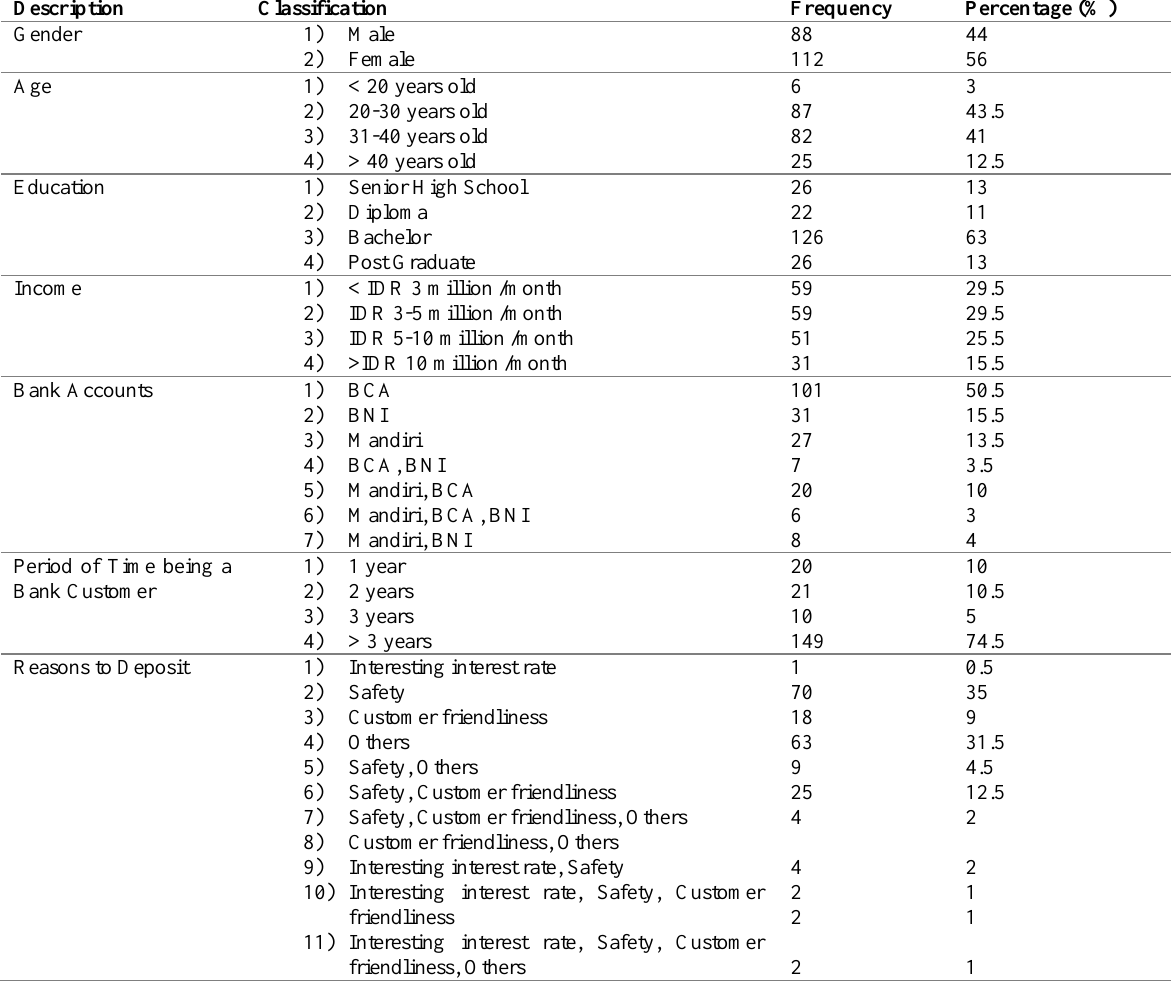
Table 2: Profile of Respondents